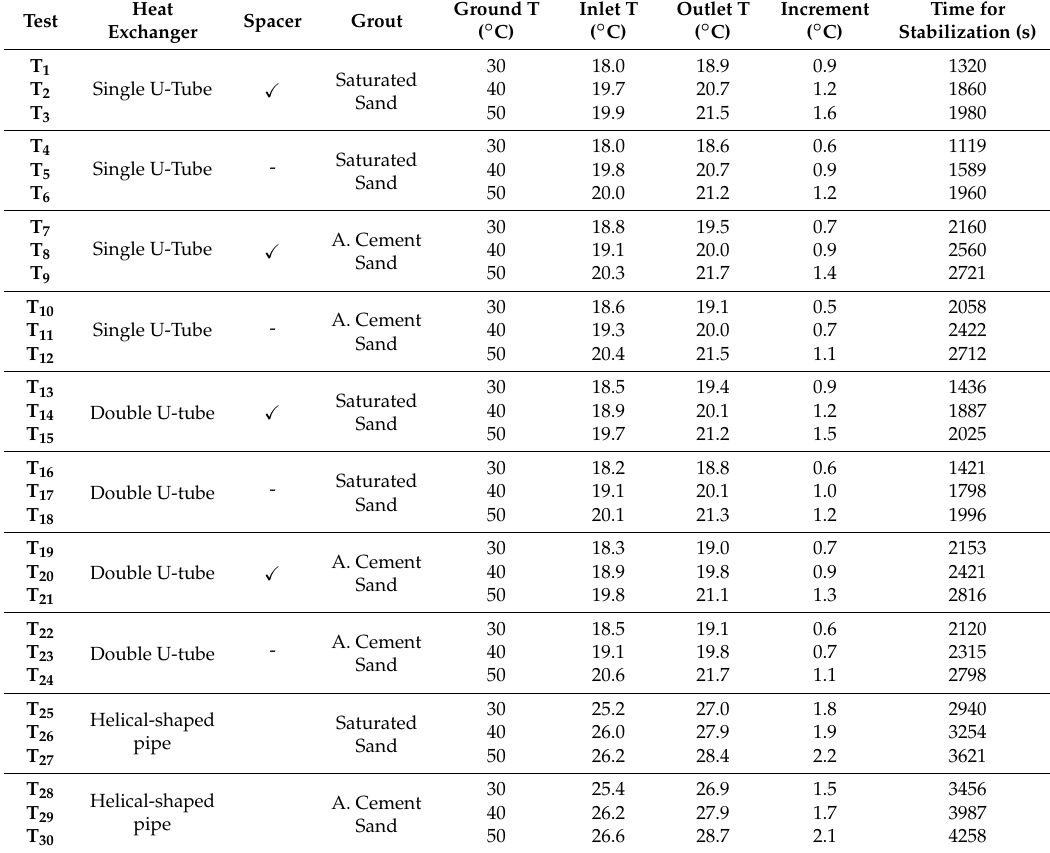
Table 3. Different tests experimented in laboratory and temperature and time